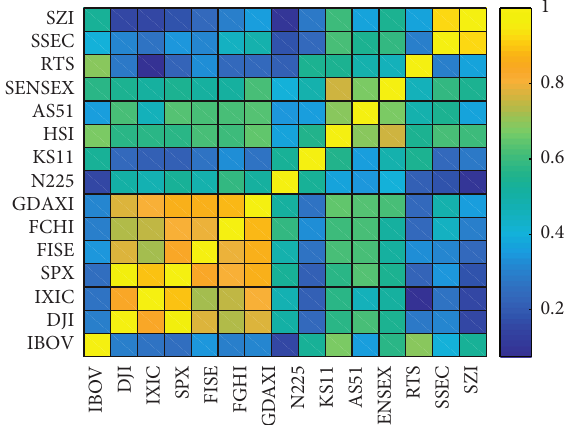
on cross-correlation 1 Figure 2: The mean of DCCA coefficients between the stock series.